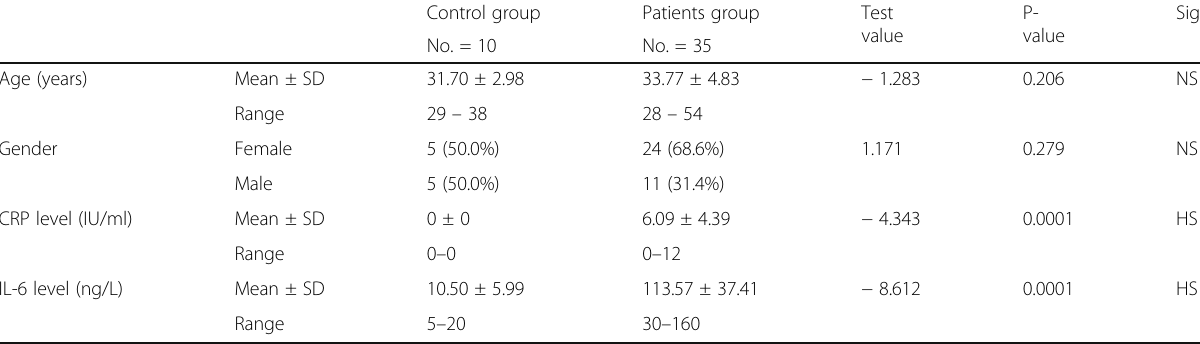
Table 1 Baseline data of patient and control groups before receiving colchicine